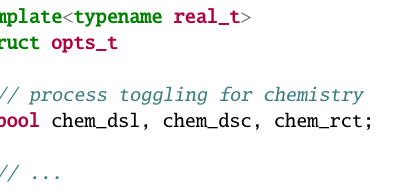
Figure A1. lgrngn::opts_t definition.